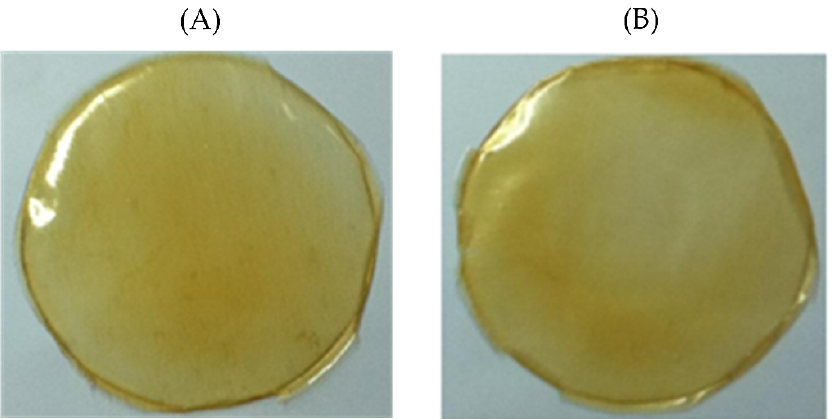
Figure 4. Antimicrobial film from chitosan ( A ) and chitosan film + 0.04% EOs ( B ).